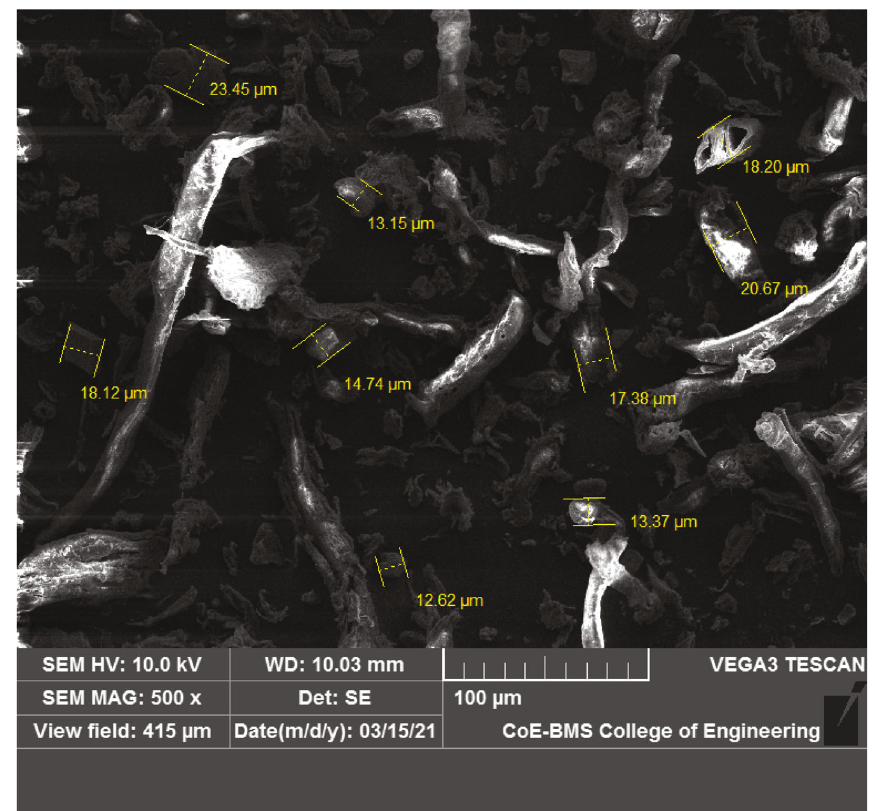
Figure 7: SEM image of mango seed shell powder.